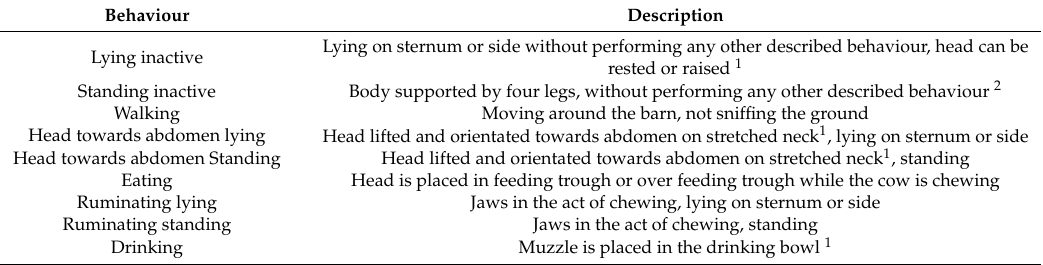
Table 1. Ethogram of cows housed in the calving